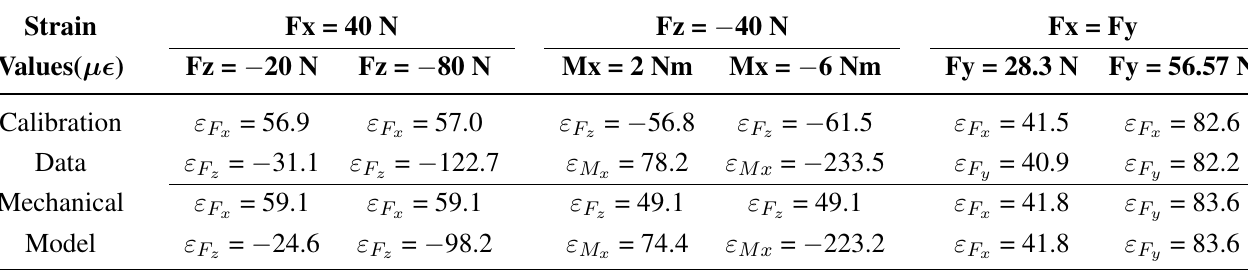
Table 2. Comparison of analytical solutions and calibration data under combined loads.